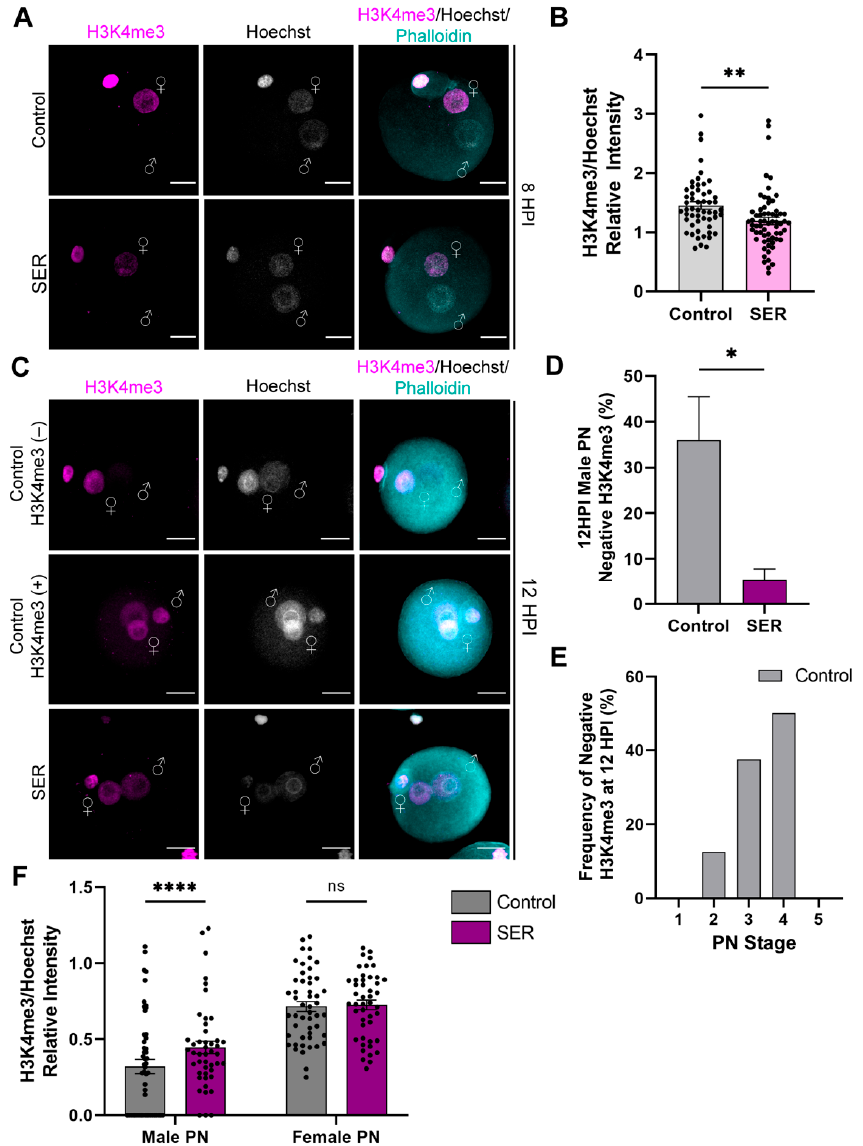
Figure 3. Post-translational histone modification H3K4me3 during pronuclear progression. ( A ) Representative confocal microscopy images of control- and SER-generated embryos at 8 HPI stained for H3K4me3 (magenta). Cortical actin cytoskeleton (Phalloidin) and DNA (Hoechst) are shown in cyan and grey, respectively. Male PN: ♂ ; female PN: ♀ ; and scale bar: 20 μ m. ( B ) Quantification of H3K4me3/Hoechst relative intensity of female PN at 8 HPI. N = 5 independent experiments; number of embryos: control = 54, SER = 64. Data are mean ± s.e.m. ** p < 0.01 (unpaired T ‐ test). ( C ) Representative confocal microscopy images of control ‐ and SER ‐ generated embryos at 12 HPI stained for H3K4me3 (magenta). Control ‐ generated embryos are additionally shown as male PN with H3K4me3 (+) or without H3K4me3 ( − ) signal. Cortical actin cytoskeleton (Phalloidin) and DNA (Hoechst) are shown in cyan and grey, respectively. Male PN: ♂ ; female PN: ♀ ; and scale bar: 20 μ m. ( D ) Quantification of male PN without H3K4me3 signal (negative H3K4me3). N = 6 independent experiments; number of embryos: control = 26 (negative)/65 total, SER: 6 (negative)/81 total. Data are mean ± s.e.m. * p < 0.05 (nonparametric test, Mann – Whitney test). ( E ) Frequency of control-generated embryos at each pronuclear stage without H3K4me3 ( − ) signal in the male PN at 12 HPI. N = 6 independent experiments; 26 embryos. ( F ) Quantification of H3K4me3/Hoechst relative intensity of male and female PN at 12 HPI. N = 5 independent experiments; number of embryos: control = 51, SER = 47. Data are mean ± s.e.m. ns p > 0.05, **** p < 0.0001 (unpaired T